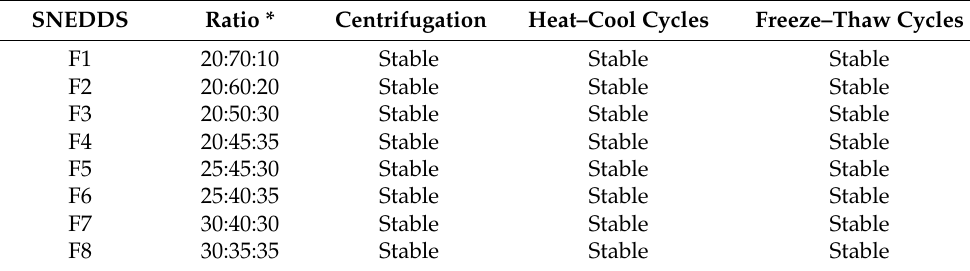
Table 2. Thermodynamic stability of the drug-loaded